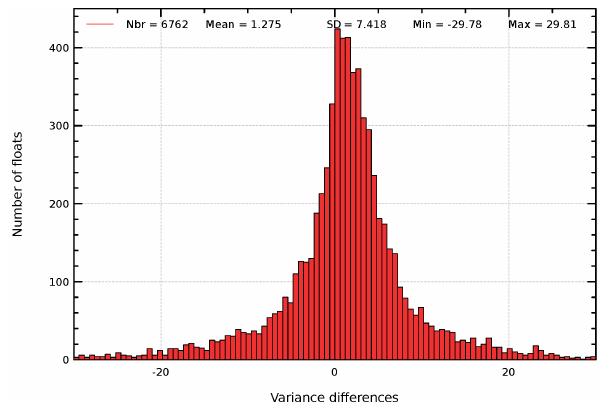
Figure 3. Histogram of the difference of variance of the SLA–DHA differences for each Argo float using successively 1 ◦ × 1 ◦ vs. 1 ◦ × 3 ◦ boxes (i.e., Variance(SLA_1x1-DHA) – Variance(SLA_1x3-DHA)) when averaging along-track Jason-1 al- timeter SLAs before collocating with Argo